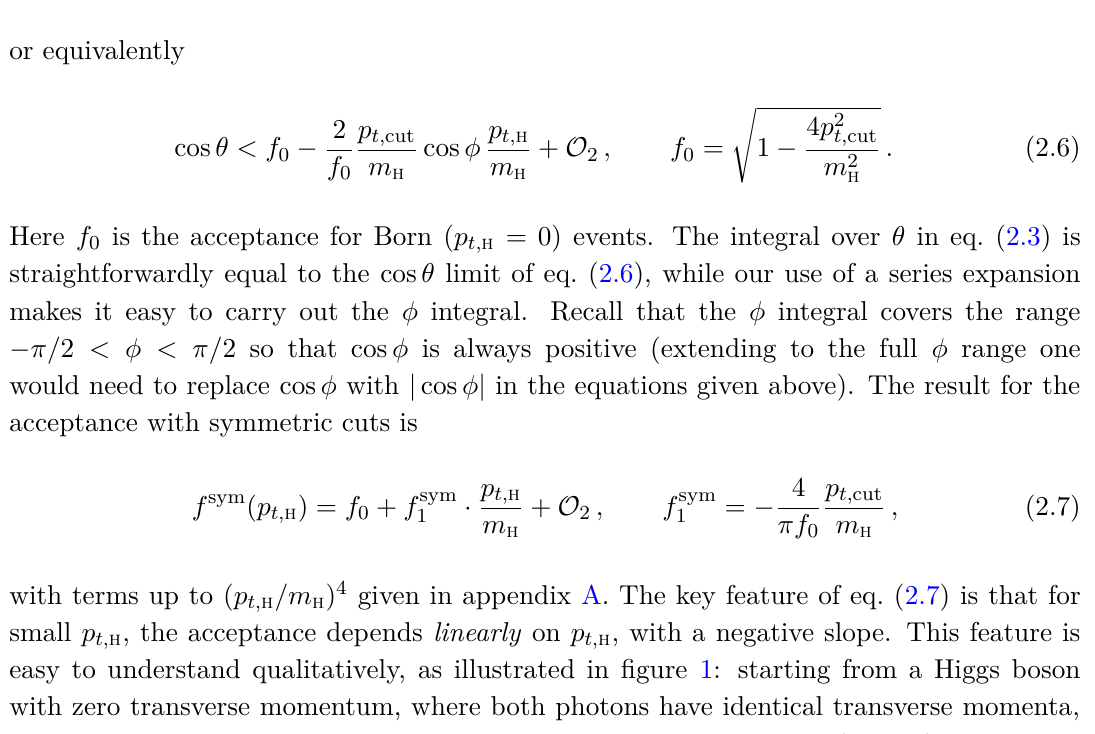
Figure 1 . Illustration of an event where both Higgs decay photons just pass a symmetric p t, cut when the Higgs boson is at rest (left), but where one of them no longer does when the Higgs boson is given a small transverse boost. This is the origin of the negative linear p t, h dependence of the acceptance in eq.